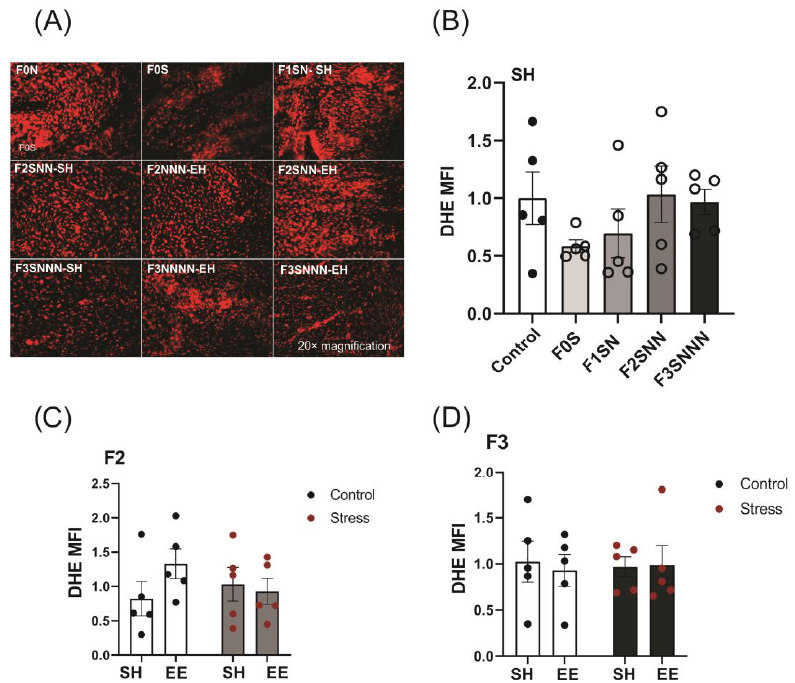
Figure 6. Uterine ROS levels were unchanged between treatments and housing conditions across the F0 – F3 generations. Four random regions of each uterus were used to measure mean fluorescence intensity (MFI) with DHE staining. ( A ) Representative images for each treatment and housing group. ( B ) Analysis of ROS levels (mean fluorescence intensity, MFI) in uterine samples from stressed dams compared to controls. Assessments of the effects of EE housing on uterine ROS levels in the ( C ) F2 and ( D ) F3 generations of animals subjected to ancestral stress. Data are compared to F0N, mean ± SEM. Ordinary one-way ANOVA ( B ) and two-way ANOVA ( C , D ) analyses were used. N = 5. SH = standard housing; EE = enriched housing; F = filial generation; S = stressed; N = non- stressed.